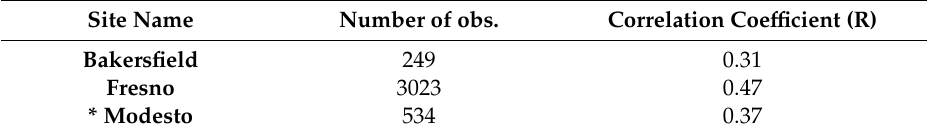
Table 3. Summary statistics between AOD and PM 2.5 at long-term co-located AERONET-AQS sites.